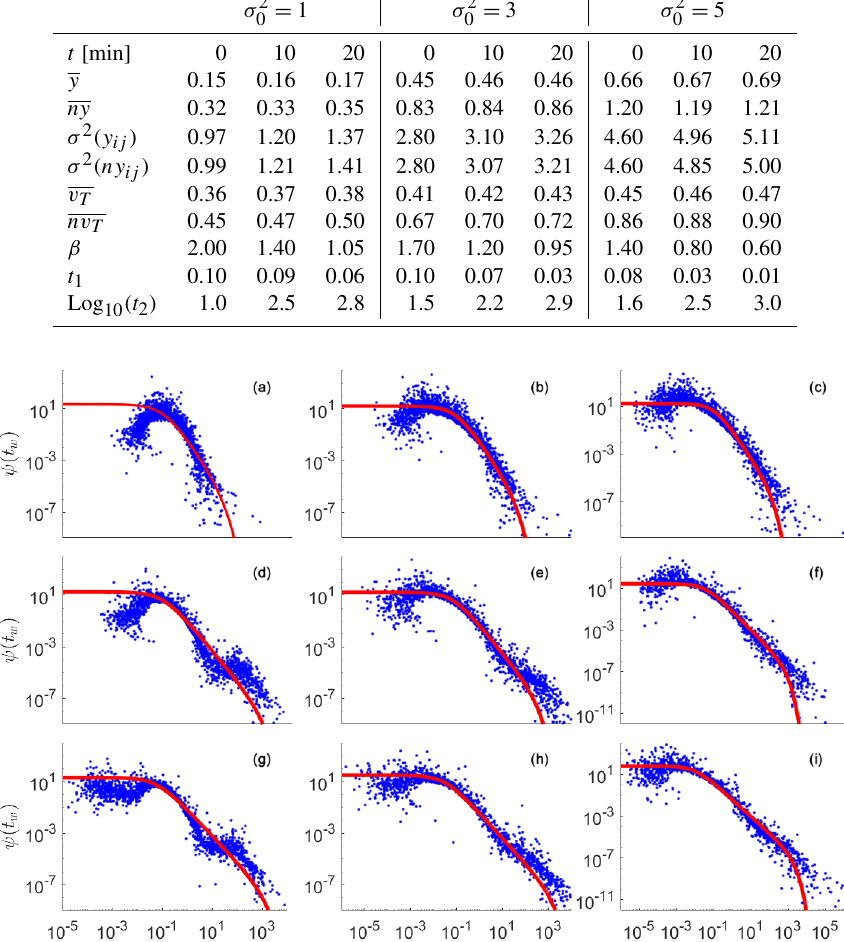
Figure 2. Sample and modeled probability density function ψ(t w ) of particle waiting times for a tracer test performed on the conductivity field prior to reaction for those associated with reactive simulation times of 10 and 20min. Results correspond to σ 2 and right columns, respectively) and t = 0 (a–c) , 10 (d–f) , and 20min (g–i) . Values of TPL parameters estimated by calibrating model Eq. (6) on the sample distributions are listed in Table